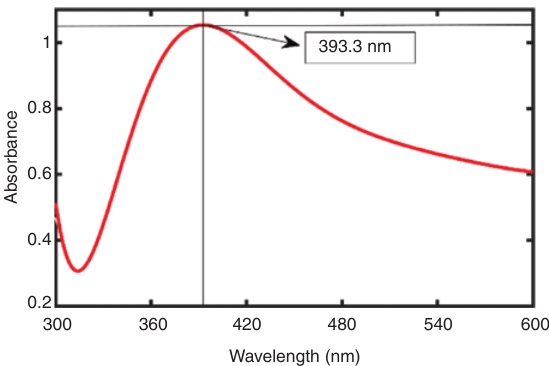
Figure 2: UV-Vis absorption spectrum of nano Ag with peak occur- ring at about 393 nm.